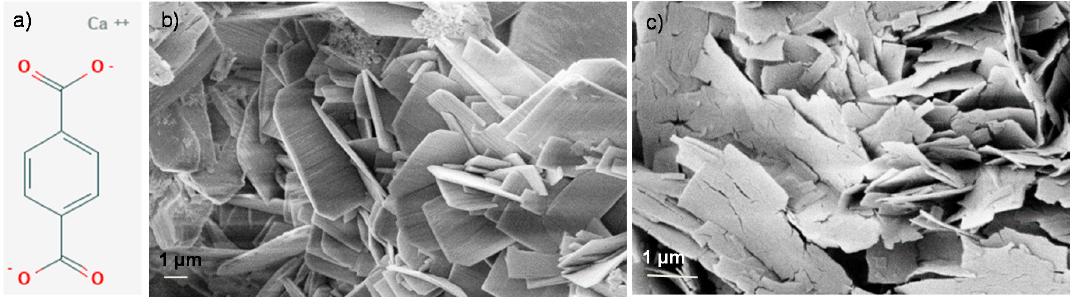
Figure 1. Chemical structure of calcium terephthalate salts ( a ) and FESEM morphology in their hydrated ( b ) and anhydrous state ( c ).